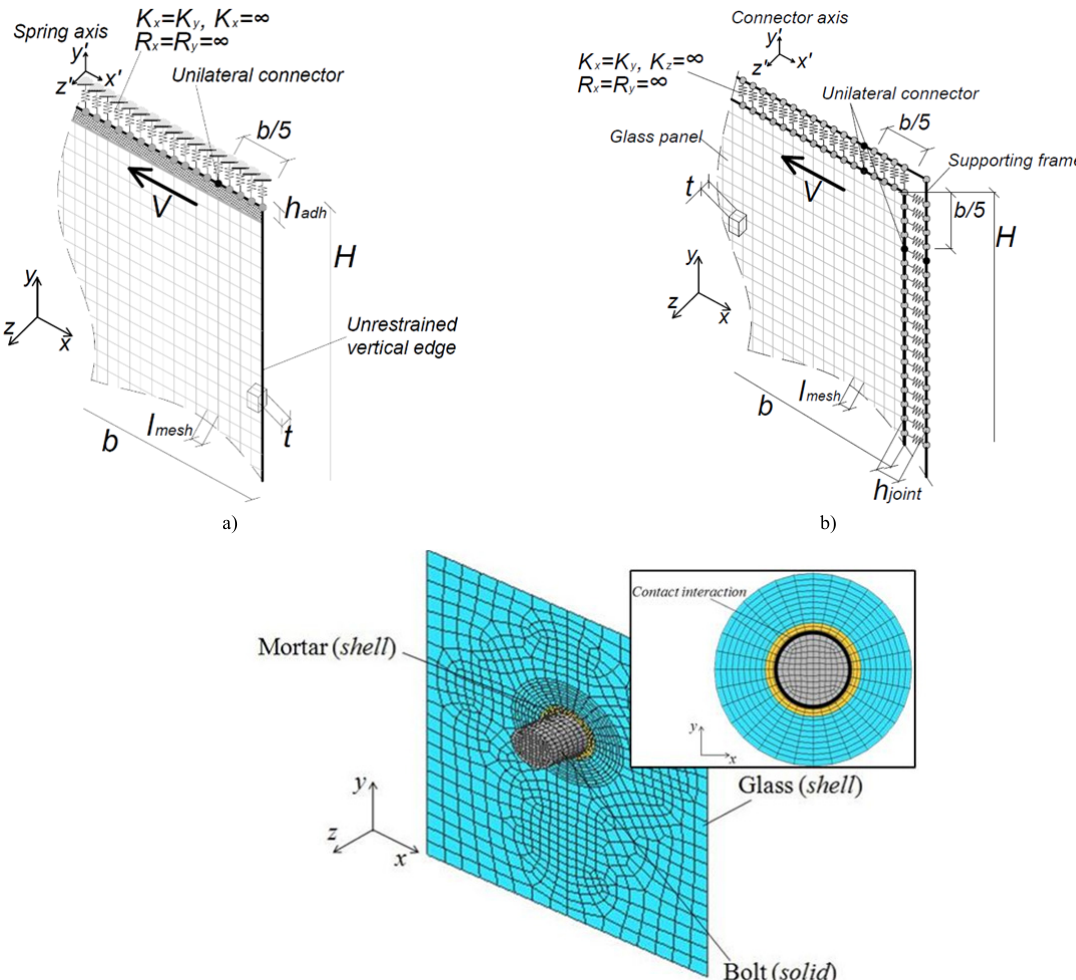
Fig. 3 Overview of the typical FE modelling approach for the implementation of the restraint details in glass shear walls. a) Linear adhesive joints, b) metal frame with interposed adhesive joints and c) mechanical point-fixing